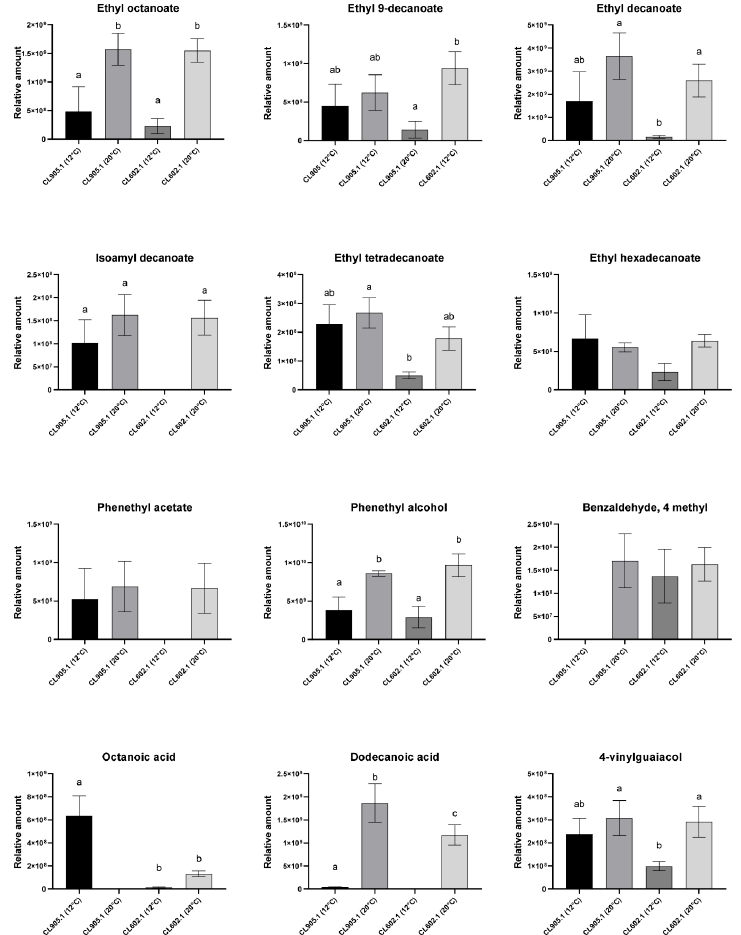
Figure 5. Relative amounts of main volatile compounds identified in fermented wort at 12 and 20 °C. CL905.1 (Choshuenco National Park) and CL602.1 (Antillanca National Park) were fermented at 12 °C and 20 °C, respectively. Different letters reflect statistically significant differences between strains with a p -value < 0.001, one-way ANOVA. No-letters strains do not show statistically significant differences.